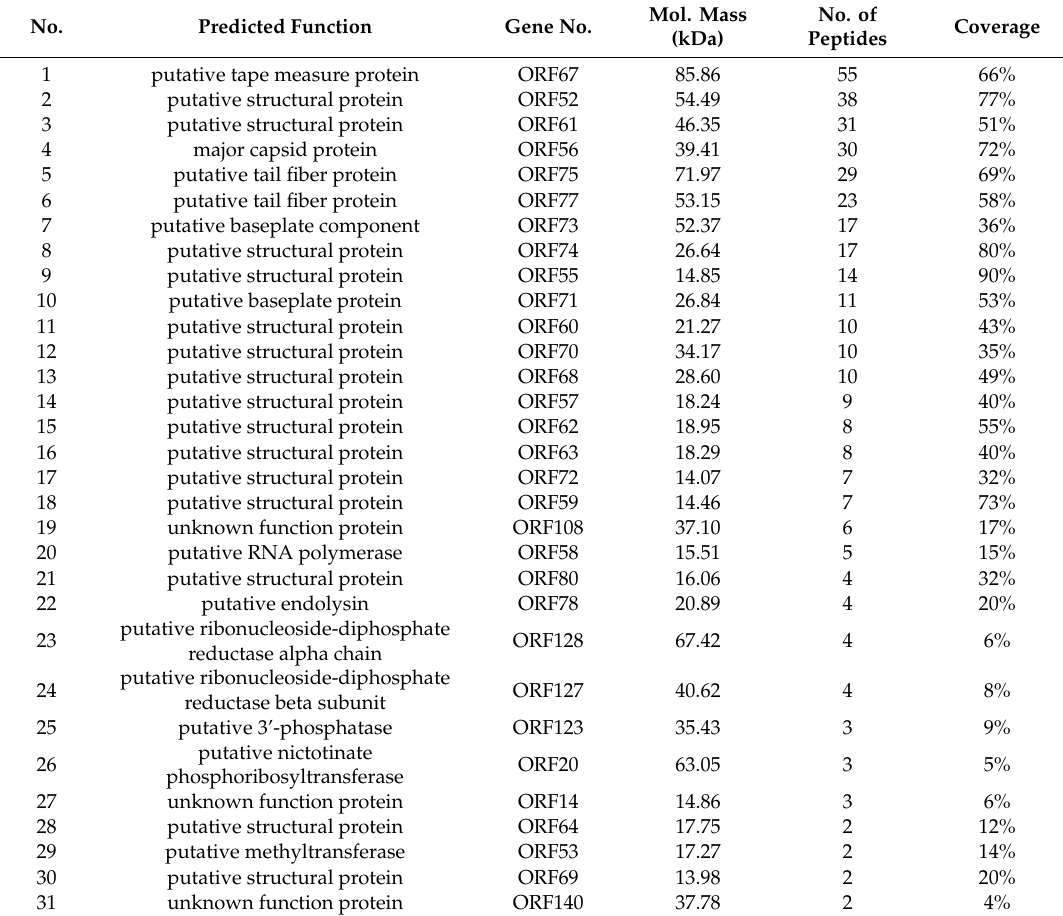
Table 2. Genes encoding virion proteins in vB_PaeM_SCUT-S2 identified by mass